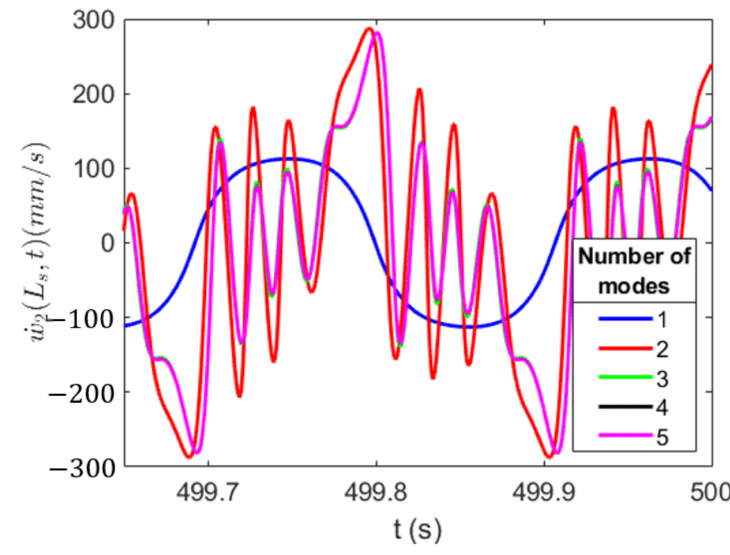
Figure 29. Time history of the absorber’s velocity at 29.2982 rad / s